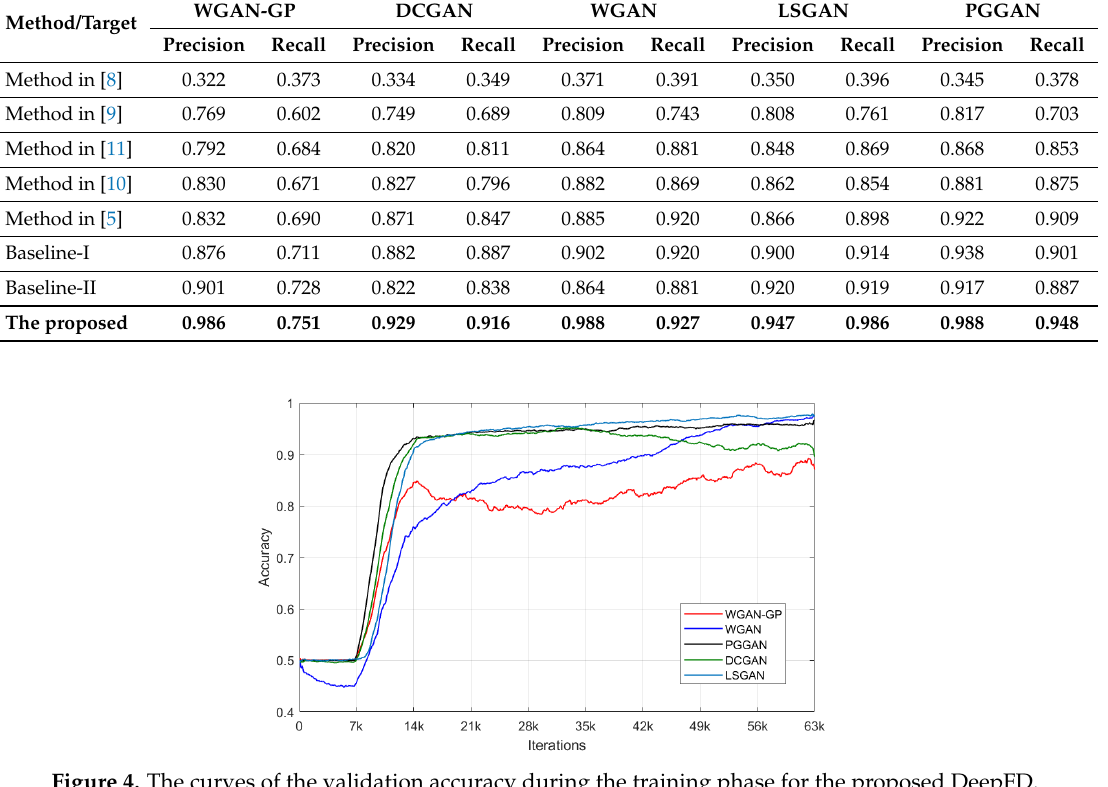
Figure 4. The curves of the validation accuracy during the training phase for the proposed